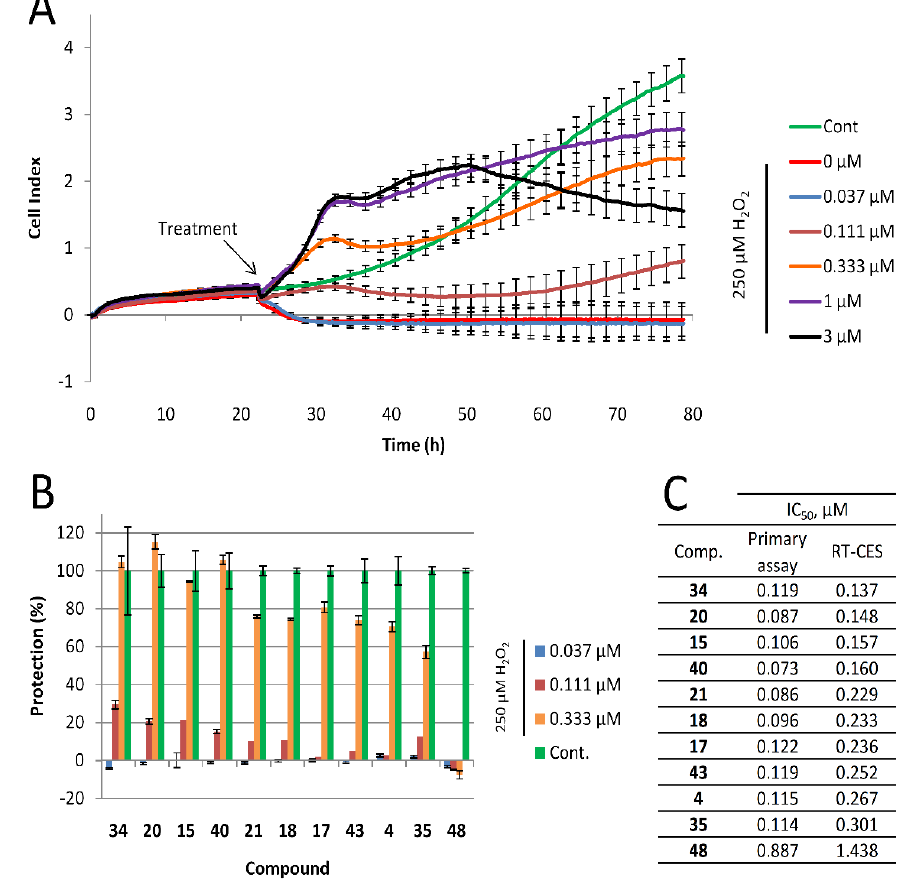
Figure 3. Real-time cytoprotection assay. ( A ): Real-time viability data traces of the most active 34 analog were followed for 60 h after treatment. ( B ): Cytoprotective activity of the tested compounds 24 h after treatment. Percentages were calculated in relation to non-treated and hydrogen peroxide-only treated cell data. ( C ): Comparison of IC 50 values determined from the primary (resazurin, end-point) assay and the real time assay 24 h after treatment.